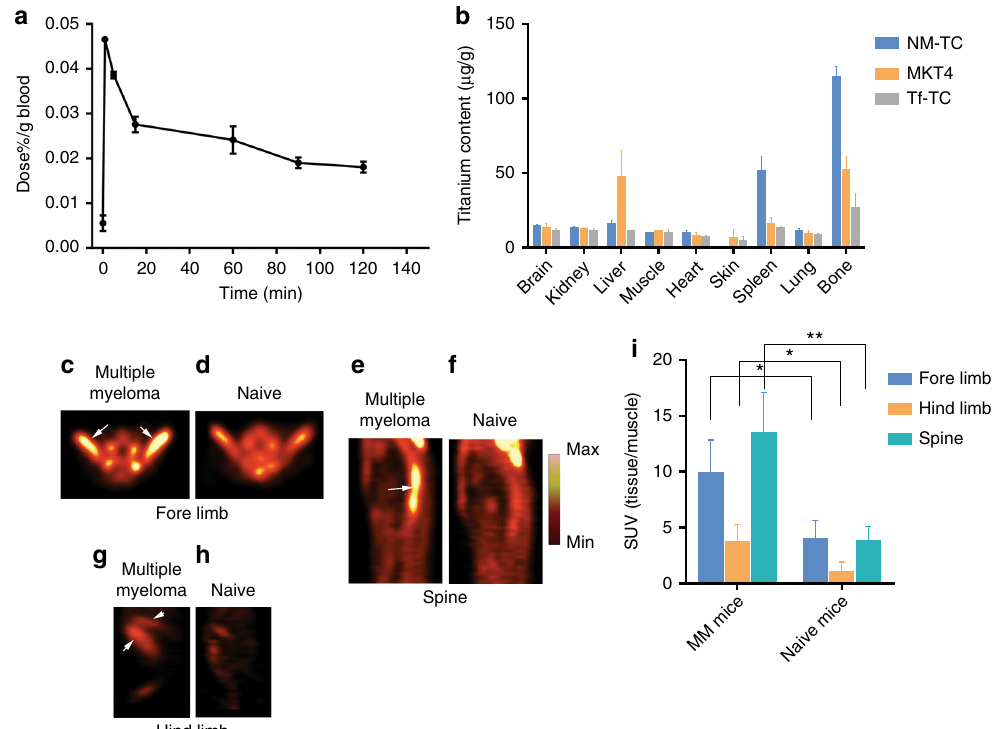
Fig. 2 Monitoring nanomicelles biodistribution and spread of multiple myeloma in vivo. a Pharmacokinetics of NM-TC in rats using coupled plasma optical emission spectrometry. Half-life is 123.4 min. b Comparison of biodistribution in mice of targeted NM-TC and pristine TC in vivo showing highest uptake and retention in bones and spleen, characteristic of multiple myeloma, 2 h post injection. 18 FDG-PET images showing increased uptake of 18 FDG in mouse forelimbs, spine, and hind limbs of mice with multiple myeloma ( c , e , g ) compared to naive mice ( d , f , h , i ). Comparison of standard uptake values (SUV) of 18 FDG in multiple myeloma vs. naive mice in various bones. Values are means ± s.e.m. * P < 0.05, ** P < 0.01. n = 5 mice for each of the